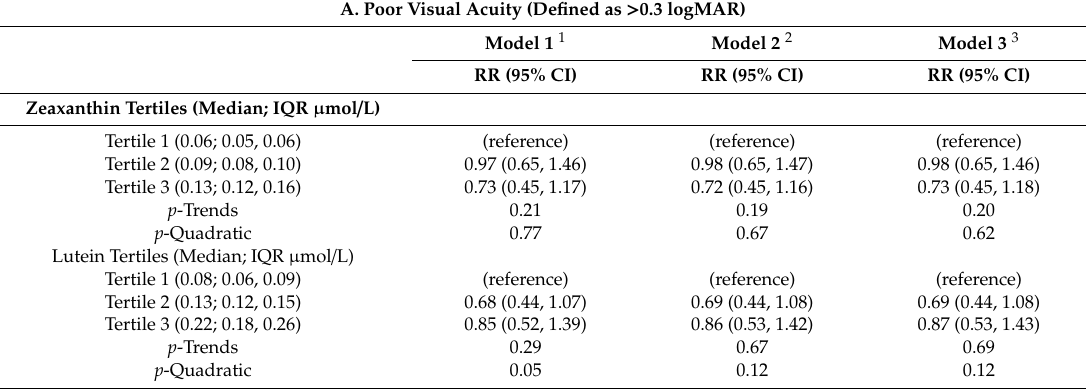
Table 3. Associations of maternal lutein and zeaxanthin with poor visual acuity ( A ) and logMAR visual acuity ( B ) in GUSTO children without myopia, hyperopia, and astigmatism ( n =